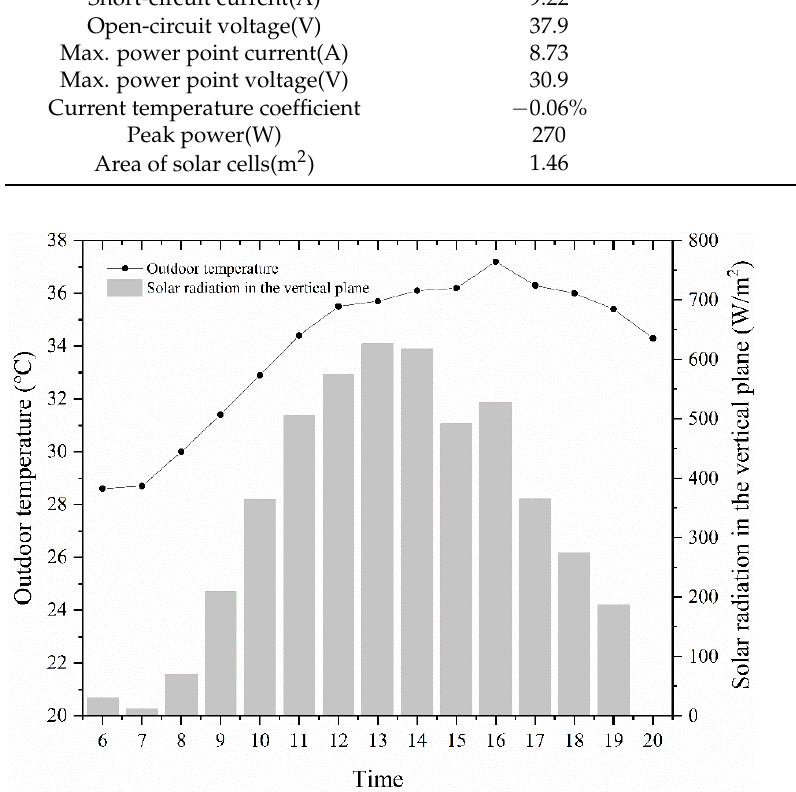
Figure 7. Outdoor weather parameters on a typical summer day.